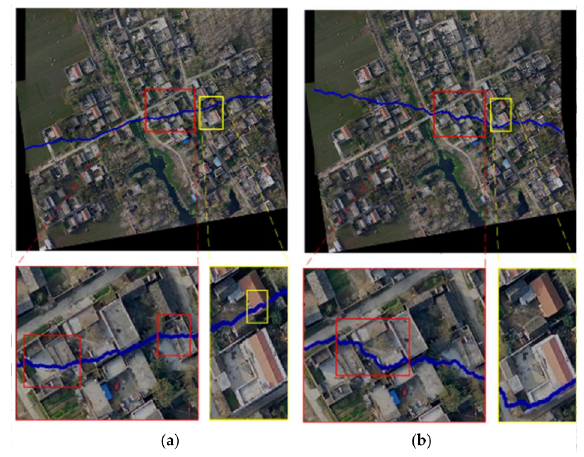
Figure 2. The mosaic results using the existing methods for two image pairs. ( a ) The Duplaquet’s method; ( b ) the method introduces the fourth horizontal direction based on the Duplaquet’s